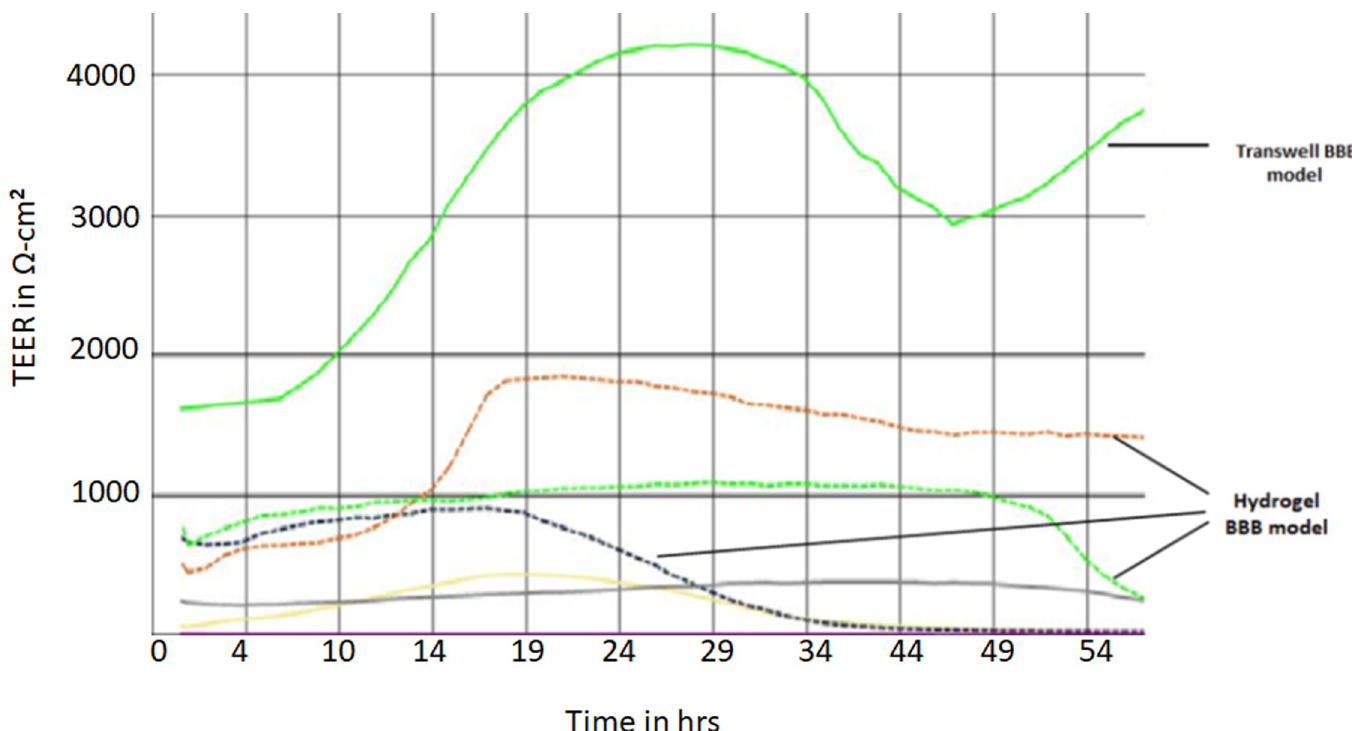
Fig 4. Trans endothelial electrical resistance of 5 hydrogel cultures and 1 matched culture on 0.4 μ m pore-size filter only (no gel) measured for 54hrs after culture set up, using a Cellzscope. Each trace represents the resistance from 1 hydrogel or transwell, measured at 1 minute intervals.